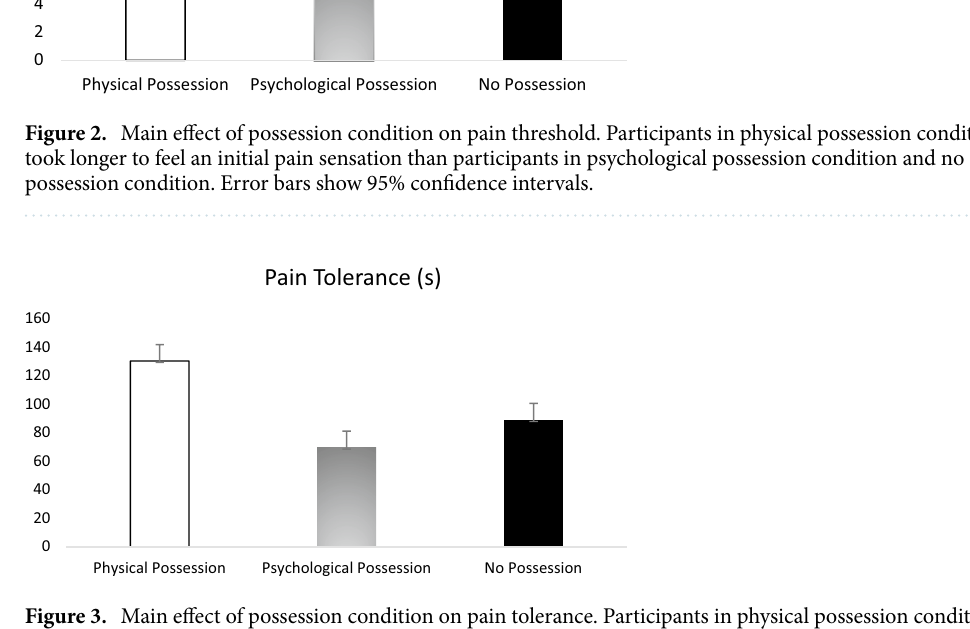
Figure 3. Main effect of possession condition on pain tolerance. Participants in physical possession condition showed longer pain tolerance than participants in psychological possession condition and no possession condition. Error bars show 95% confidence